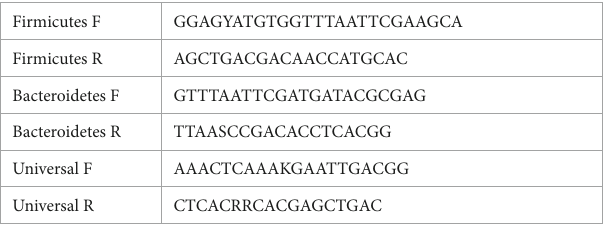
TABLE 1 The primers specific for bacterial phyla Bacteroidetes and Firmicutes and a pair of universal primers. Firmicutes